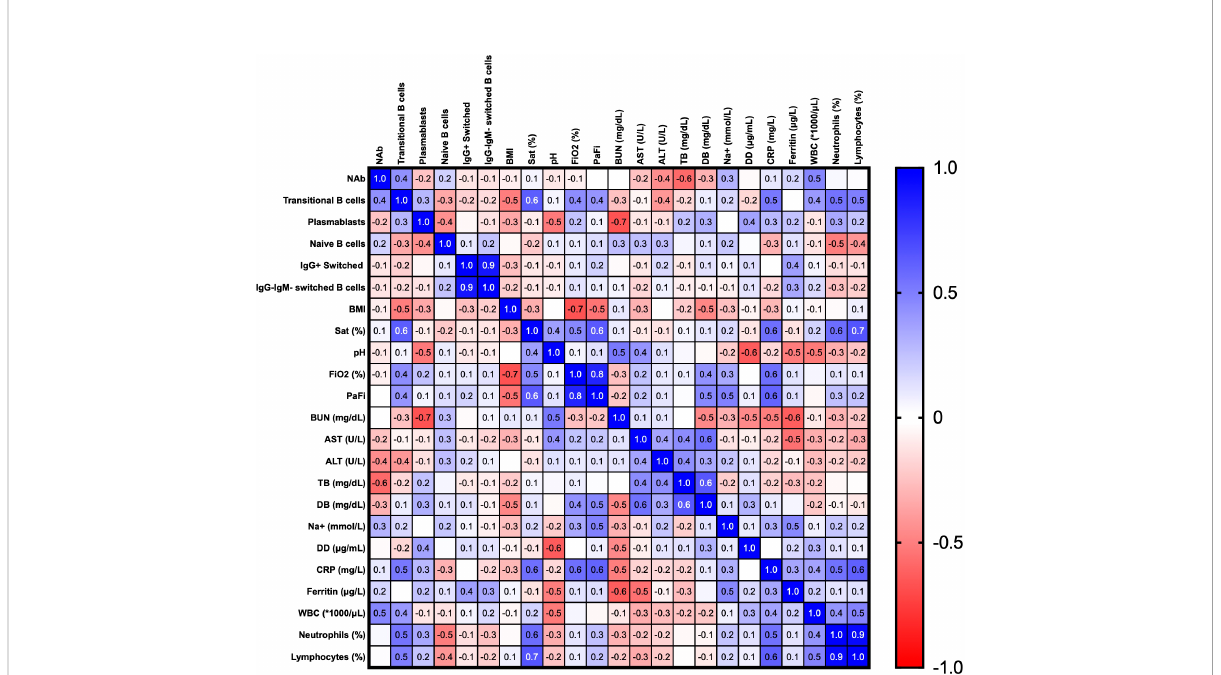
FIGURE 8 Correlation matrix of clinical parameters and B cells subsets in the hospitalized and ICU patients at the recruitment time. Spearman ’ s correlation coef fi cients are plotted, and the scale colored reveals the strength of correlations (shades of red= negative, shades of blue= positive). *NAb: neutralizing antibodies, BMI: body mass index, Sat (%): oxygen saturation, FiO 2 : fraction of inspired oxygen, PaFi: ratio of arterial oxygen partial pressure to fractional inspired oxygen, BUN: blood urea nitrogen, AST: aspartate aminotransferase, ALT: alanine transaminase, TB: total bilirubin, DB: direct bilirubin, DD: D-dimer test, CRP: C-reactive protein, WBC: white blood